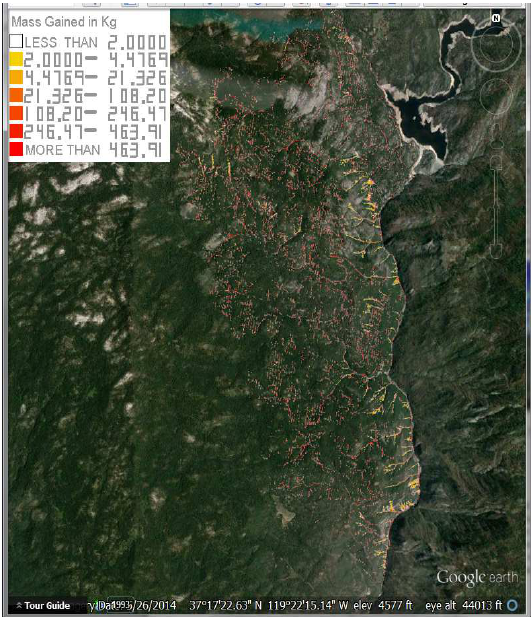
Figure 8. Dry ravel predictions for the French Fire displayed in Google